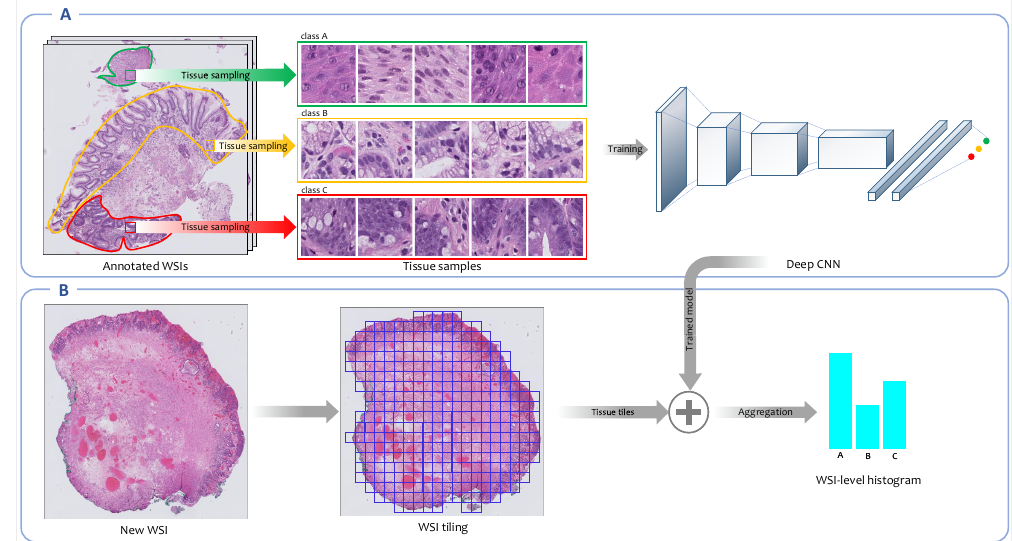
Figure 2. Overview of the fully supervised feature extraction framework. ( A ) A convolutional neural network (CNN) is trained on high-resolution tissue tiles sampled from annotated regions of WSIs in the training set. ( B ) Next, the trained model is employed to output the class’ probability distributions for each high-resolution tissue tile generated from new WSIs. The patch-level probabilities corresponding to all patches derived from a WSI are aggregated into WSI-level probabilities